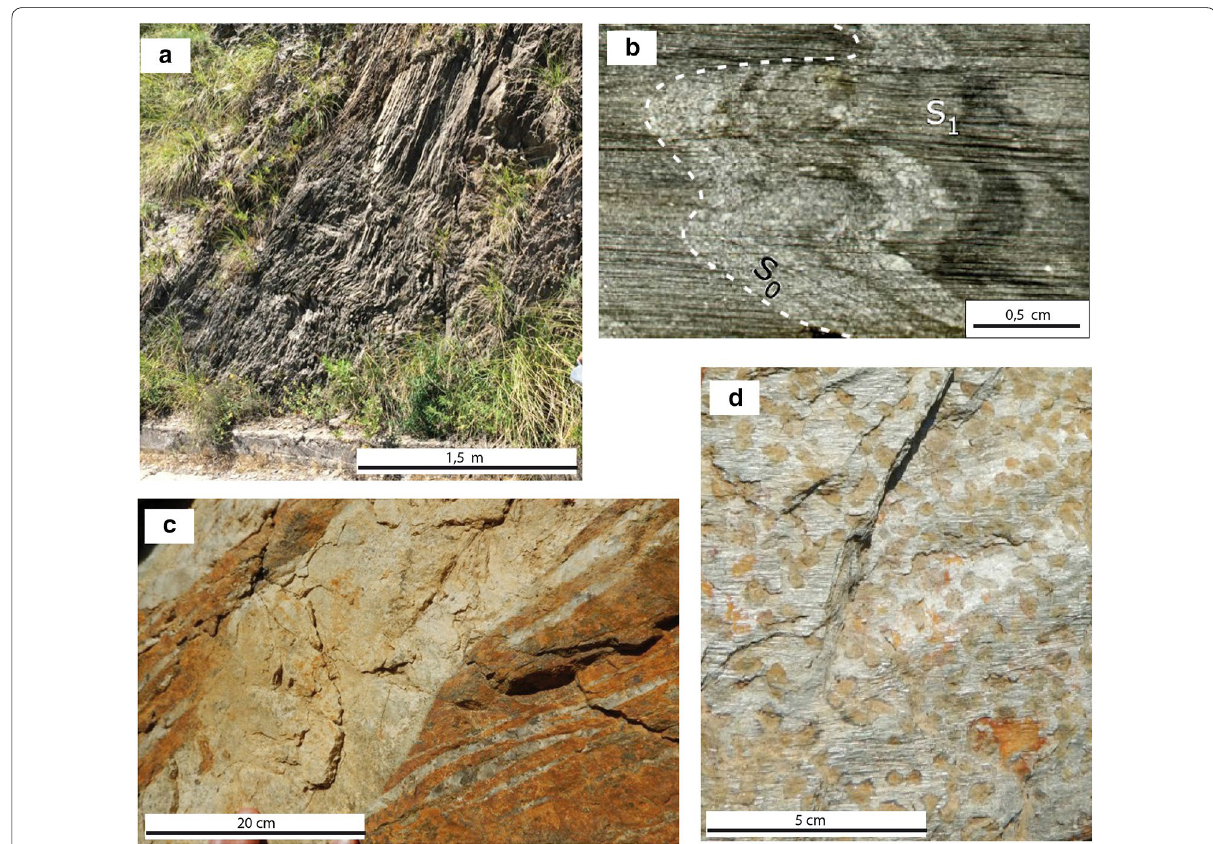
Fig. 9 a Calabria upper crust phyllites and metasandstones of the low grade unit of Stilo-Bivongi (Fiumara di Stilaro); b microscopic fabric of phyllite samples collected close to Bivongi village. S1 foliation in phyllite is parallel to axial plane of folds affecting S0 layering; c decimetre-thick granodioritic dyke within the low-grade host rock close to the margin of the Serre batholith near Stilo; d spotted schist in the aureola of Serre batholith near Stilo (see details Festa et al.